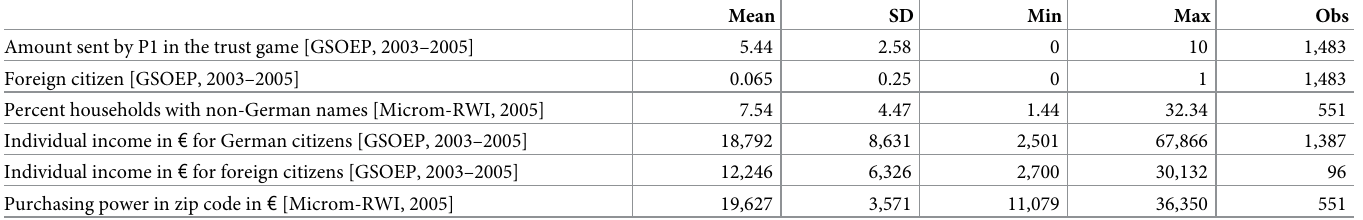
Table 1. Descriptive statistics for Player 1’s in trust game in GSOEP